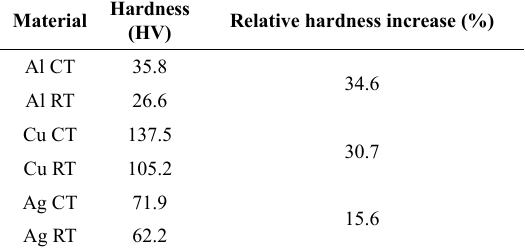
Table 1. Hardness of materials rolled up to approx. 99%.